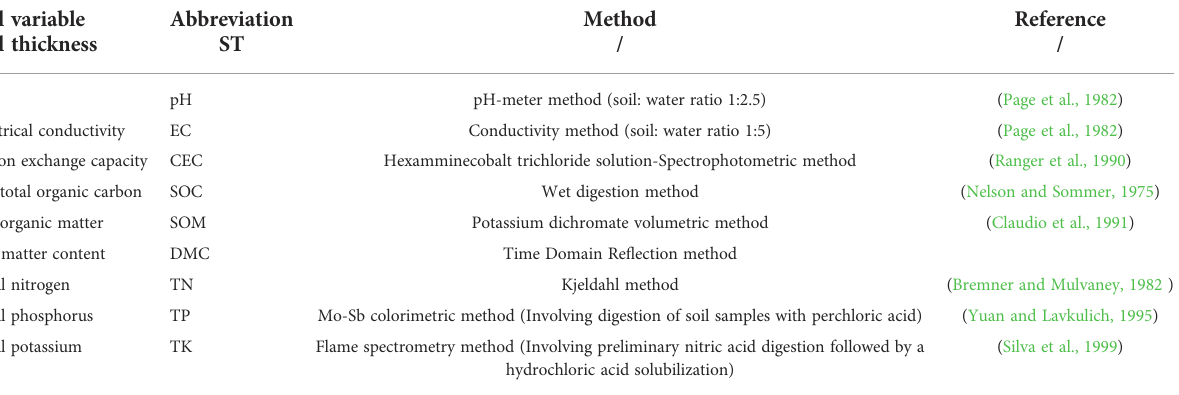
TABLE 2 Analysis method of soil